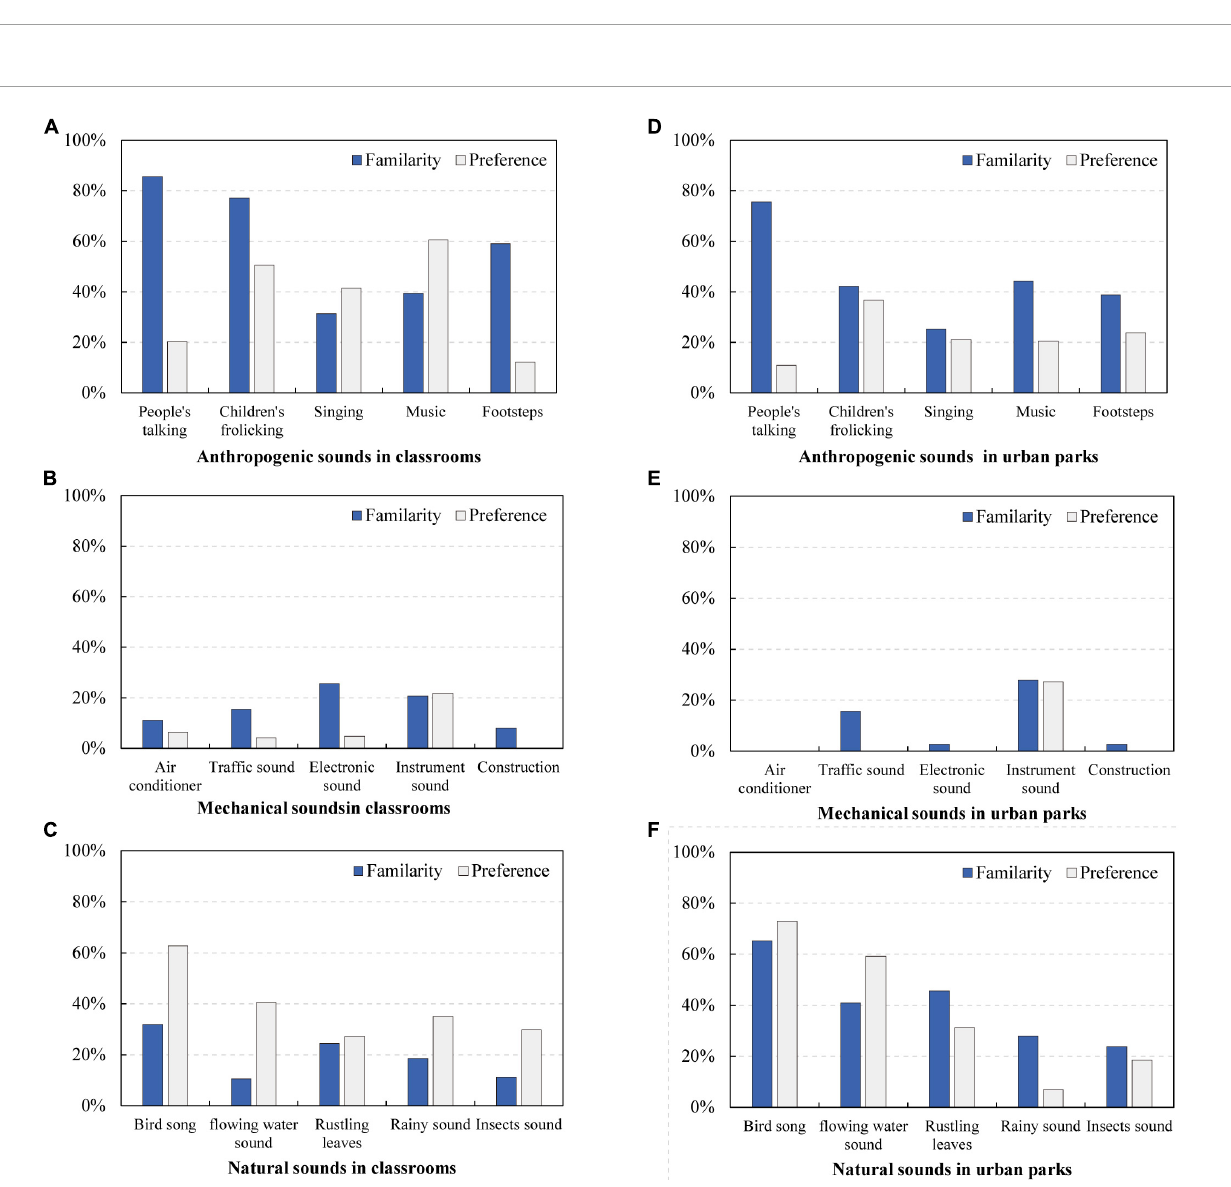
FIGURE9 Potential restorative sounds reported by children. (A) Anthropogenic sounds in classrooms; (B) mechanical sounds in classrooms; (C) natural sounds in classrooms; (D) anthropogenic sounds in urban parks; (E) mechanical sounds in urban parks; (F) natural sounds in urban